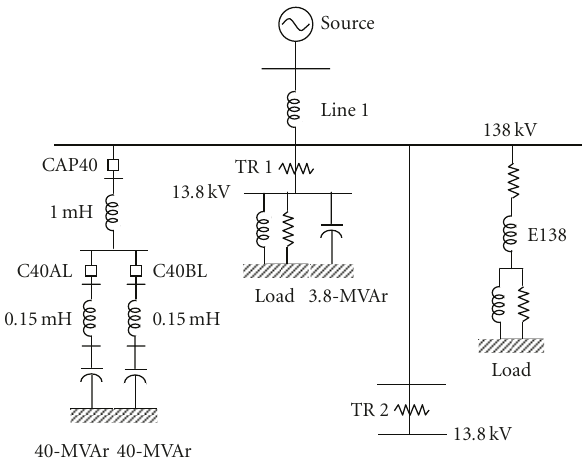
Figure 7: Single-line diagram of a 138kV 60 Hz illustrative system.